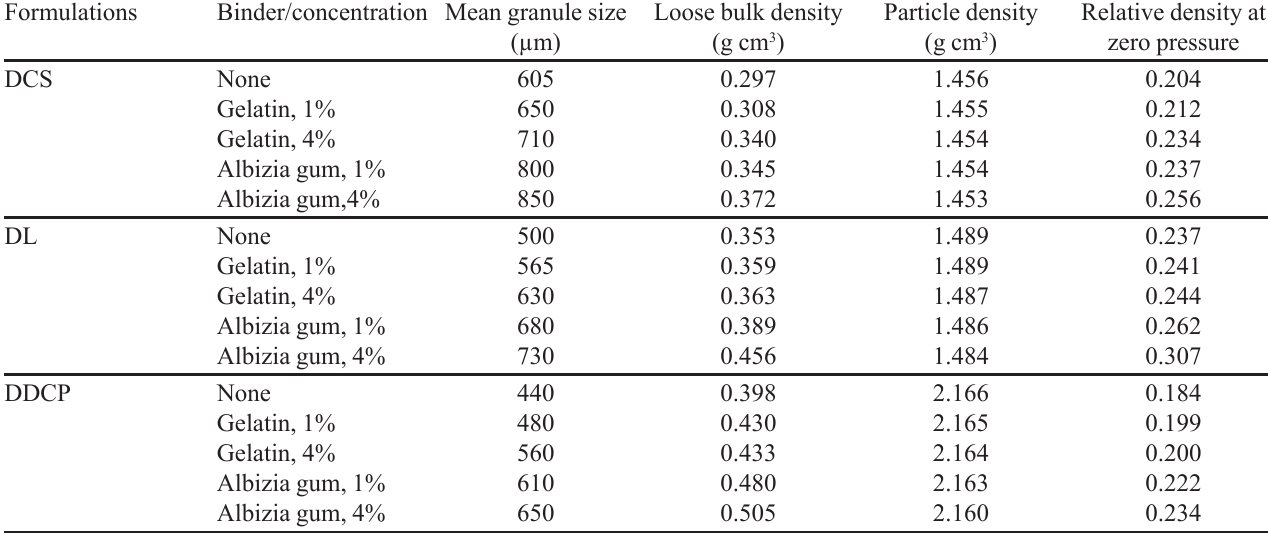
TABLE III - Granule properties of the formulations